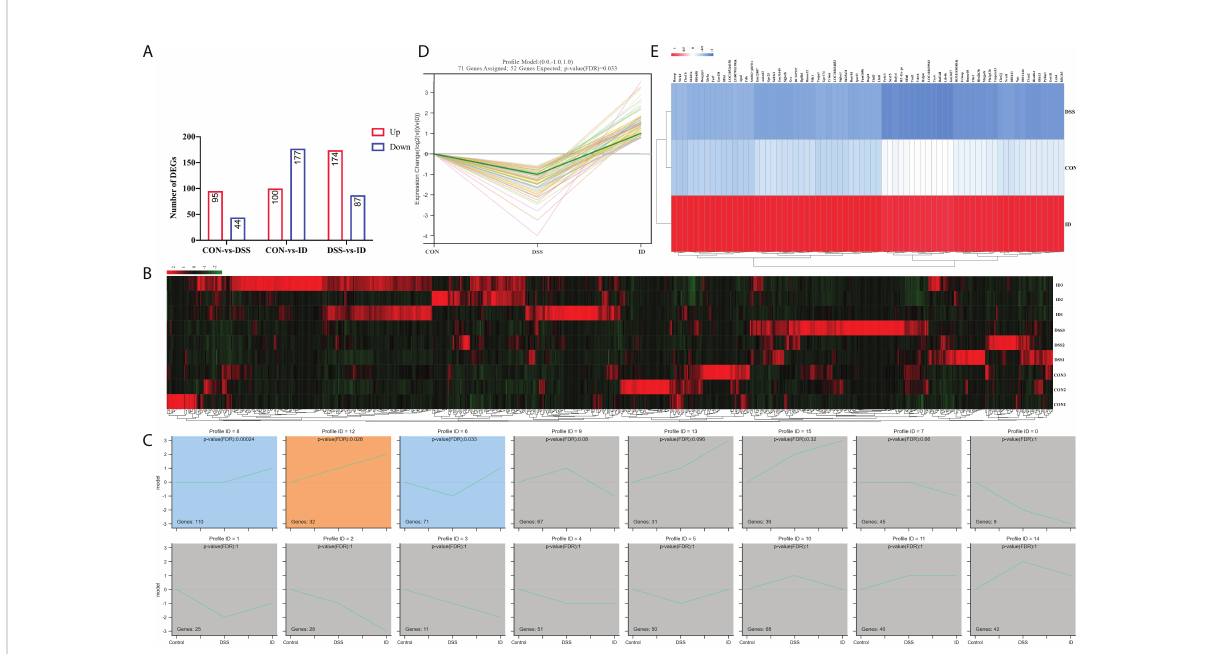
FIGURE 3 Regulation of colonic genes by IPA in DSS-induced colitis mice. (A) RNA-Seq analysis reveals DEGs among different groups. Red and blue represent the number of upregulated and downregulated genes, respectively. (B) Hierarchical clustering heatmap of different samples based on identi fi ed DEGs. (C) Modules in different colors represent different expression patterns that were signi fi cantly enriched by STEM analysis (nonsigni fi cant modules in grey). (D) Trend graph of all genes under pro fi le 6, where the thick green curves indicate the expression trend across all genes in a module. (E) The heatmap of genes from pro fi le